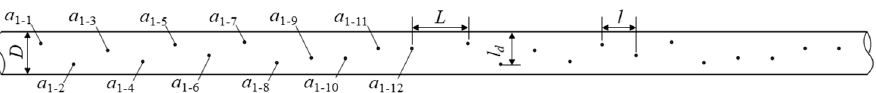
Figure 1. Sketch of orifice arrangement on a part of the micro-sprinkling hose.